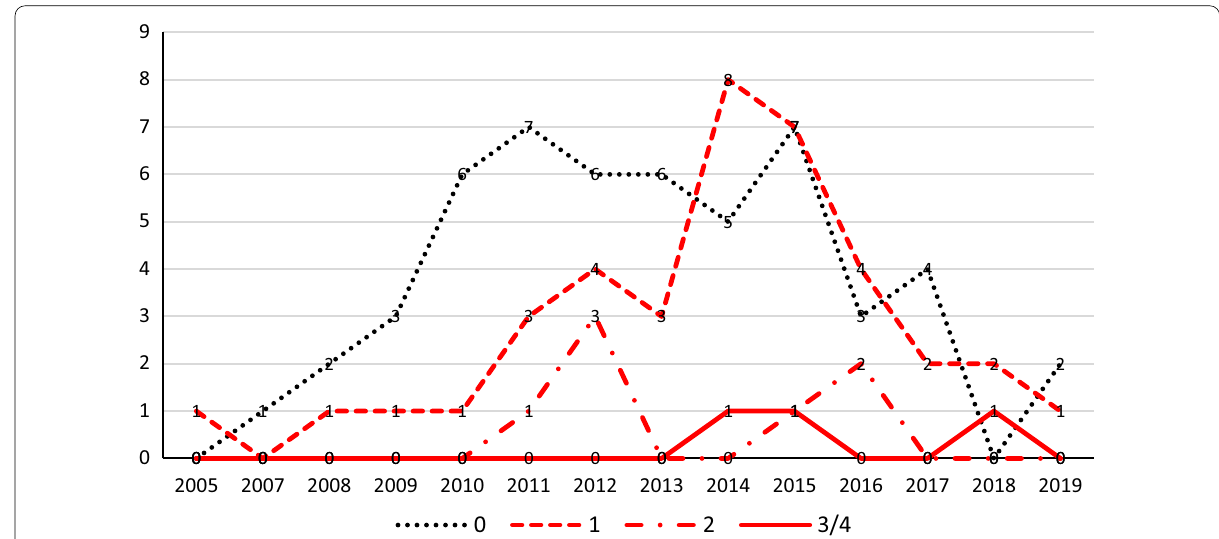
Fig. 4 Distribution of highly cited research articles across different journal categories over the years. (Note: 0 specified, 1 journals with a single discipline of STEM specified, 2 = disciplines of STEM specified.)